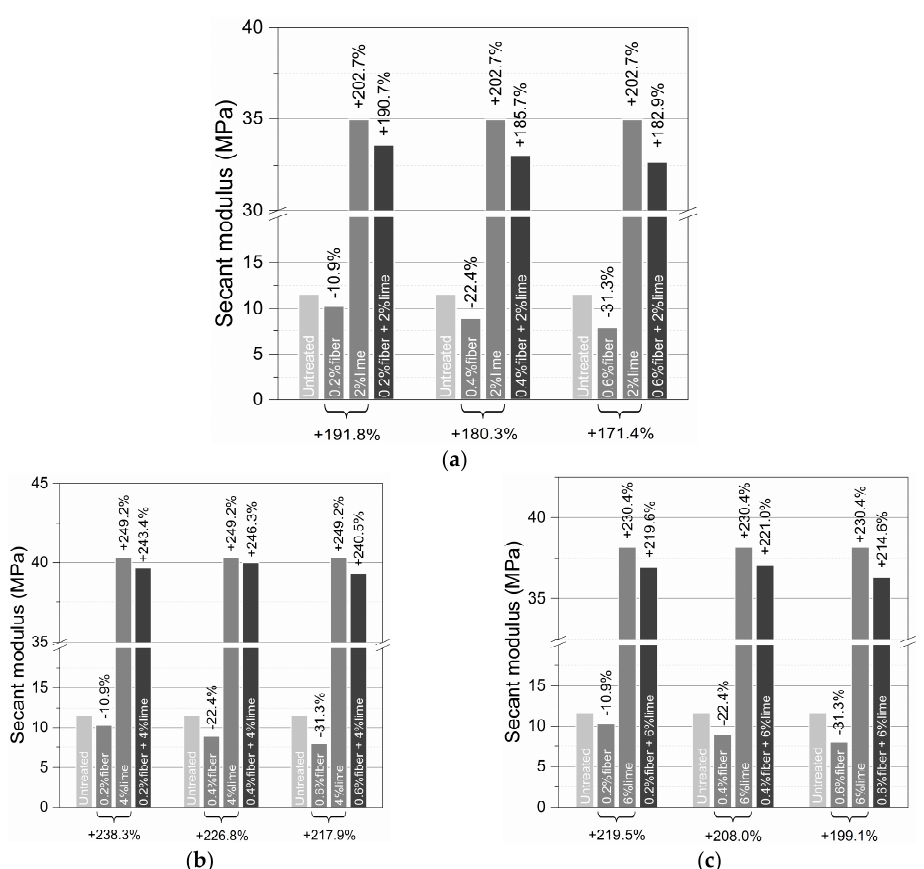
Figure 5. Secant moduli at a 1.2% strain level tested at σ 3 = 200 kPa: ( a ) 2% lime content, ( b ) 4% lime content, and ( c ) 6% lime content. The percentages represent the rates of increase in the secant moduli compared to the untreated one. compared to the untreated